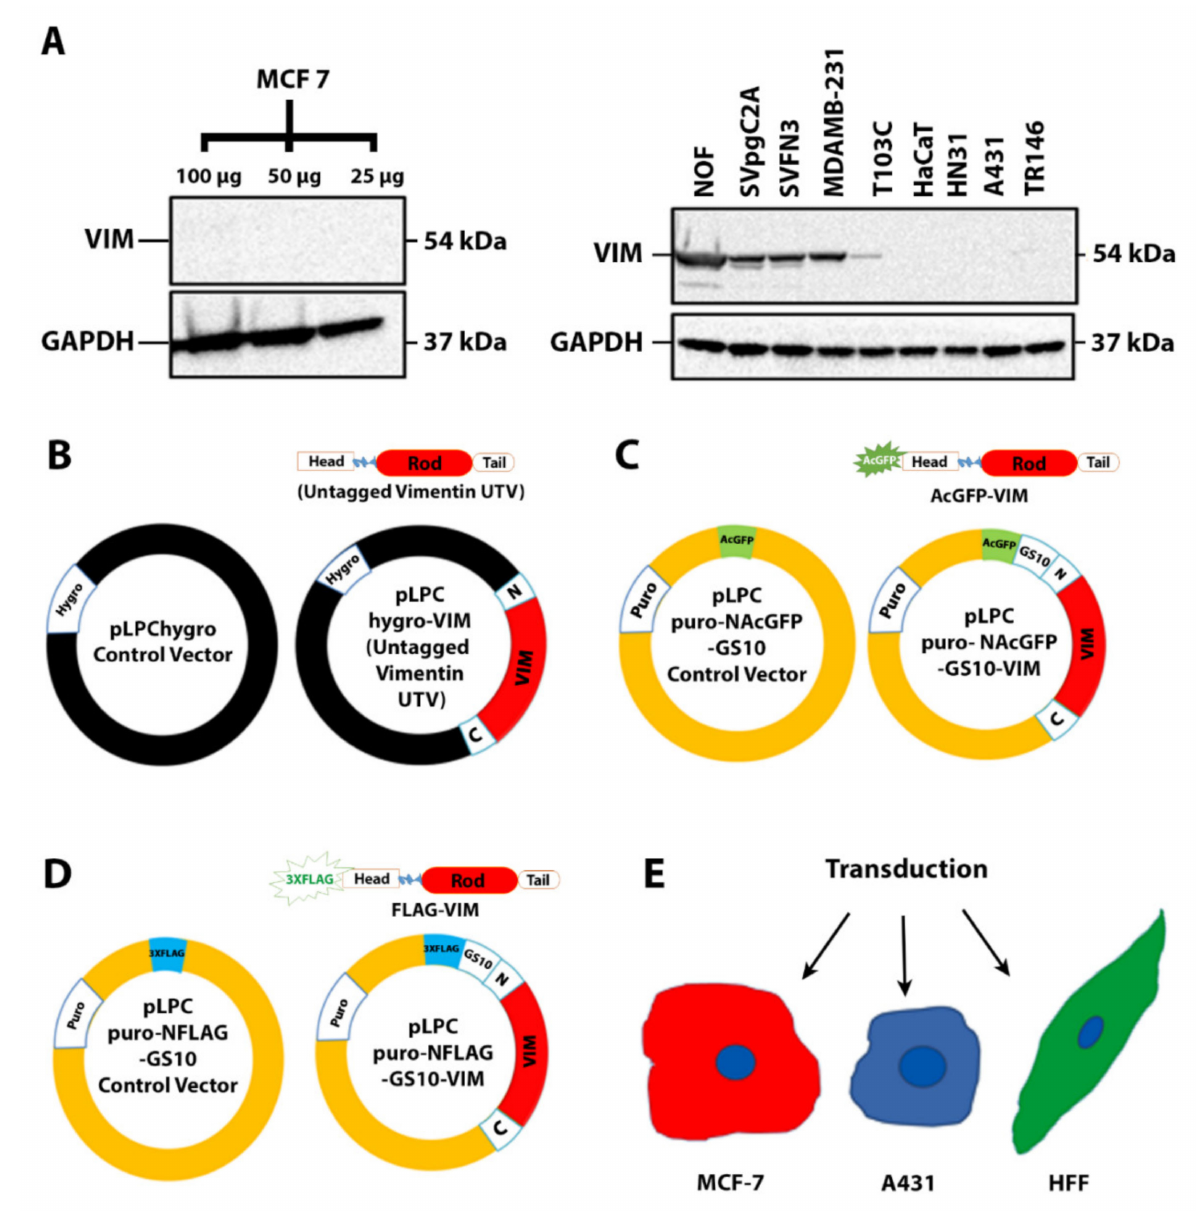
Figure 1. Graphical representation of different constructs used in this study . ( A ) Vimentin expres- sion analysed in 10 different cancer cell lines by western blotting. A total of 50 µ g total protein was loaded for all other cell lines; for MCF-7, 100, 50 and 25 µ g protein were loaded onto SDS PAGE gels. GAPDH was used as the loading control. Relevant bands were cropped from different gels and regrouped. Original blots are shown in Supplementary Figure S1. ( B ) Construct pLPChygro-VIM expressing untagged vimentin (UTV) and pLPChygro its control vector (CV); N and C are the 5 (cid:48) and 3 (cid:48) ends of vimentin cDNA, respectively, black color represents the vector backbone. ( C ) pLPCpuro- NAcGFP-GS10-VIM expressing AcGFP-VIM and pLPCpuro-NAcGFP-GS10 expressing AcGFP its CV. ( D ) pLPCpuro-NFLAG-GS10-VIM expressing FLAG-VIM and pLPCpuro-NFLAG-GS10 expressing FLAG its CV, the FLAG tag was 3 × FLAG, yellow colour in B and C represents vector backbone. ( E ): MCF-7, A431 and HFF-1 cell lines (nuclei in blue and the cytoplasm is shown in different colors) were transduced with the constructs described in ( B – D